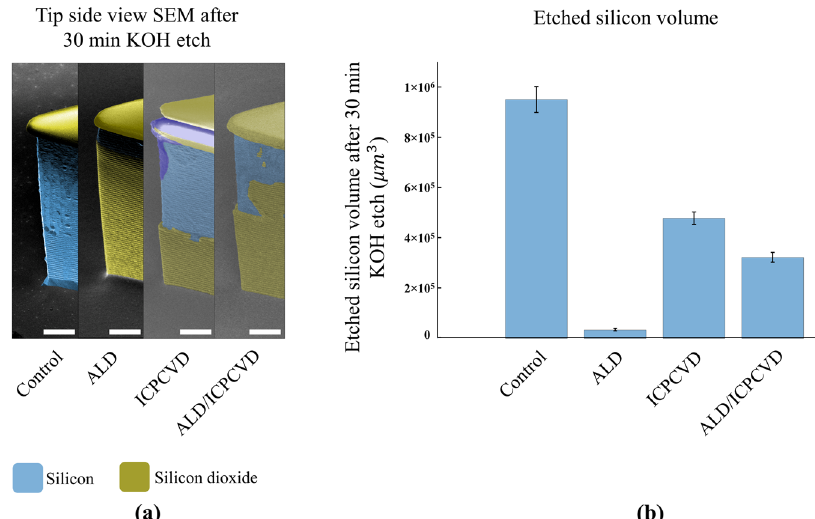
Fig. 2 Quanti fi cation of etched silicon volume after 30 min KOH etching. a Side view SEM images, as noted in Fig. 6a, from each group after 30 min KOH etching. False coloring is identical to Fig. 1. Bright purple areas on ICPCVD panel are charged up photoresist during imaging. The scale bars are 10 µm. b Comparison of etched silicon volume for each group using 3D extrapolated models. ALD-protected devices showed the least loss of silicon sidewalls whereas bare silicon was etched the most. The error bars are standard deviation of the mean for each group ( N = 3). Tukey pairwise comparisons con fi rmed signi fi cant differences for all combinations after one-way ANOVA ( p < 0.01 and 95% con fi dence level).